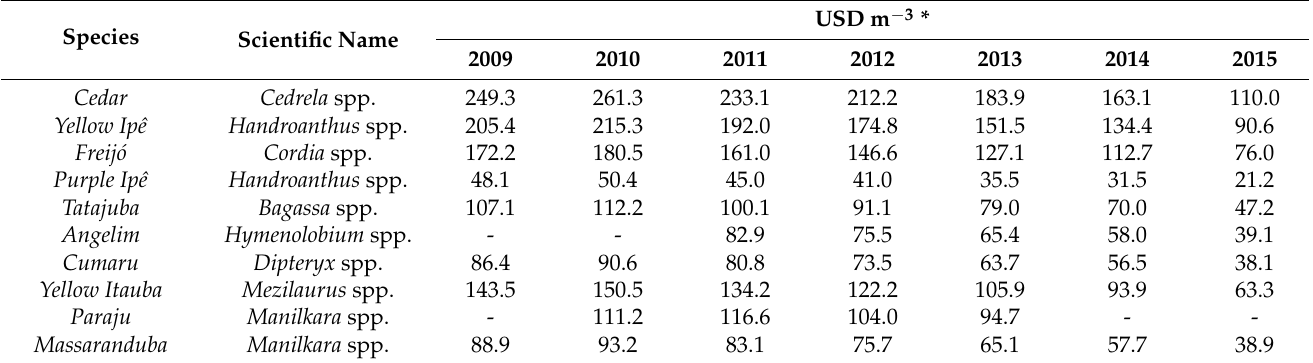
Table 4. Ten species with highest commercial value in the state of Par á